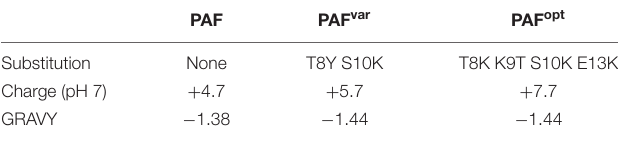
TABLE 2 | Physicochemical features of PAF and its protein